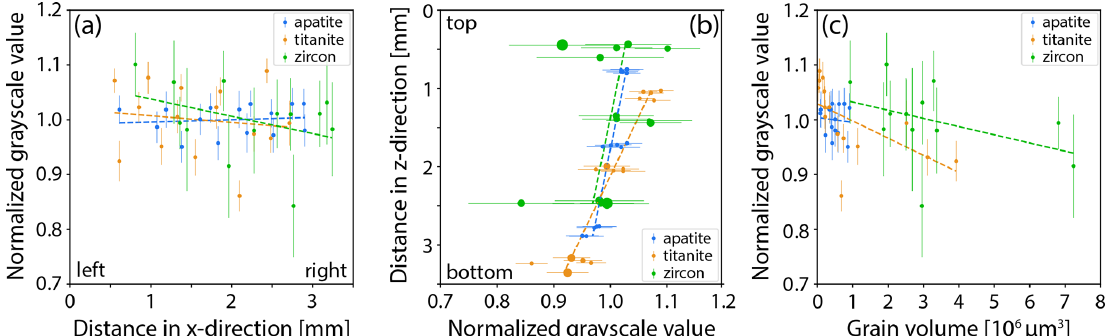
Figure 9. Plots showing the effect of spatial parameters on the grayscale values of the grains on Mount C, which contains shards of known apatite, titanite, and zircon crystals (see Fig. 2). The measured grayscale values have been normalized by the average of all grains of that mineral. Linear regressions (dashed lines) show approximate trends. (a) There is no systematic variation of normalized grayscale values with horizontal distance ( x -direction) of grain placement on the mount. (b) The normalized grayscale values of all mineral grains show a dependence on vertical distance ( z -direction) on the mount. The trends of decreasing brightness from top to bottom are roughly parallel for apatite and zircon, with around 5% total variation. Titanite shows larger grayscale variations ( ∼ 10%), which are partly due to variations in the volume of grains (size of symbol correlates with volume). Larger grains are preferentially located at the bottom of the mount, thereby amplifying this trend. (c) Grains of larger volume have lower grayscale values, likely due to the effects of beam